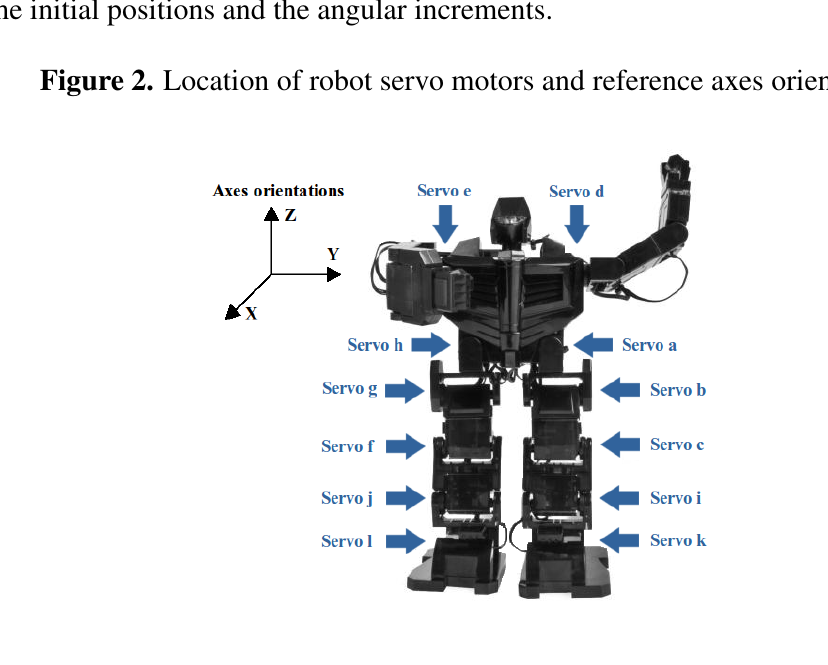
Figure 3. PWM control signals for a